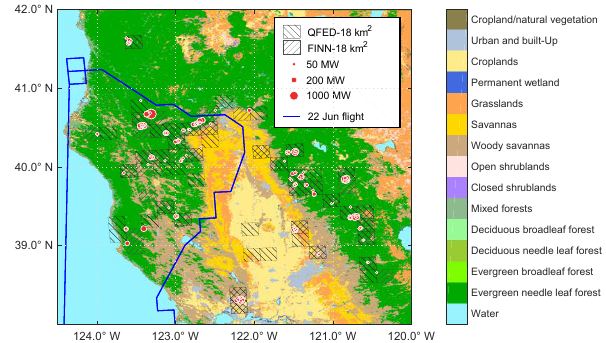
Figure 2. Land category types, MODIS fire hotspot detections on 21 and 22 June 2008, sized by FRP, and 18km × 18km gridded FINNv1.0 and QFED emission